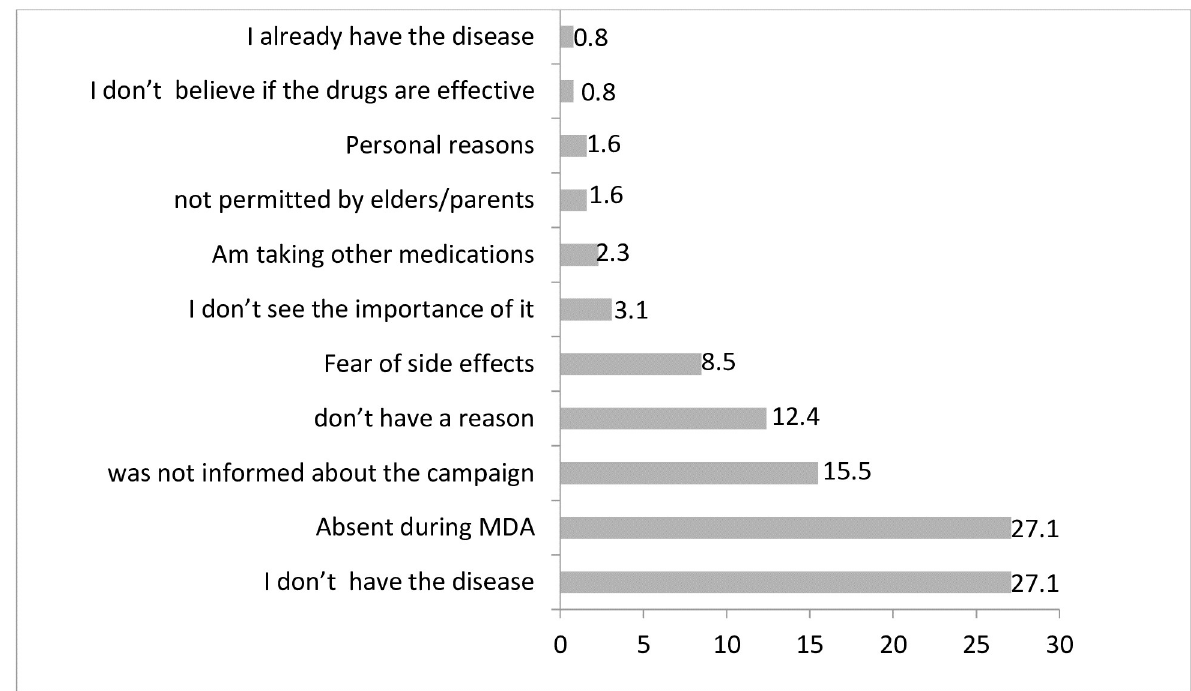
Fig 1. Percent (%) response on reasons for non-compliance to MDA (n =